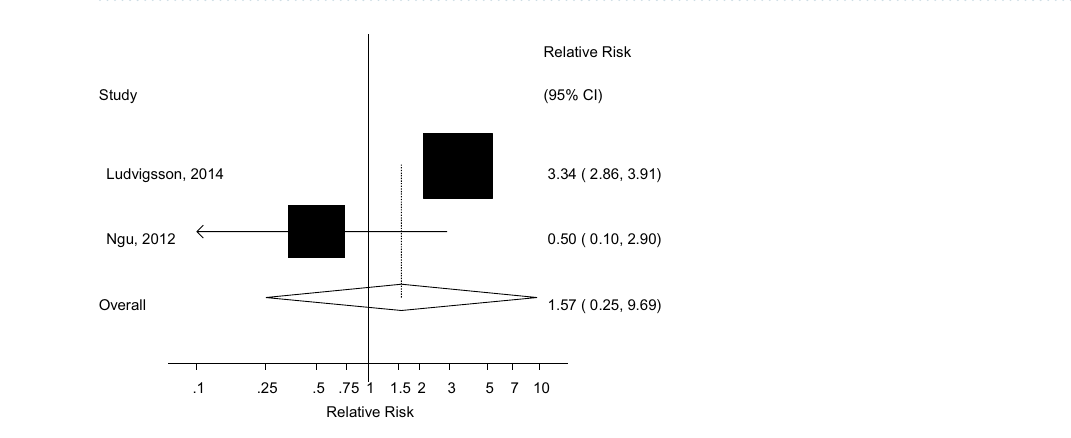
Figure 4. Primary sclerosing cholangitis and pancreatic cancer, colorectal cancer, total cancer and all-cause mortality.